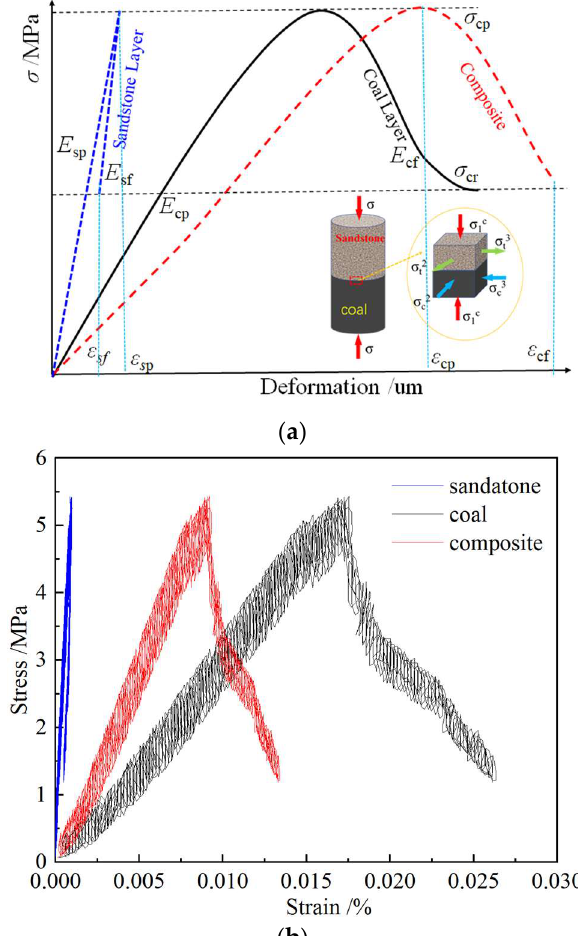
10 of 14 Figure 7. Local stress analysis of the coal–rock assemblage.